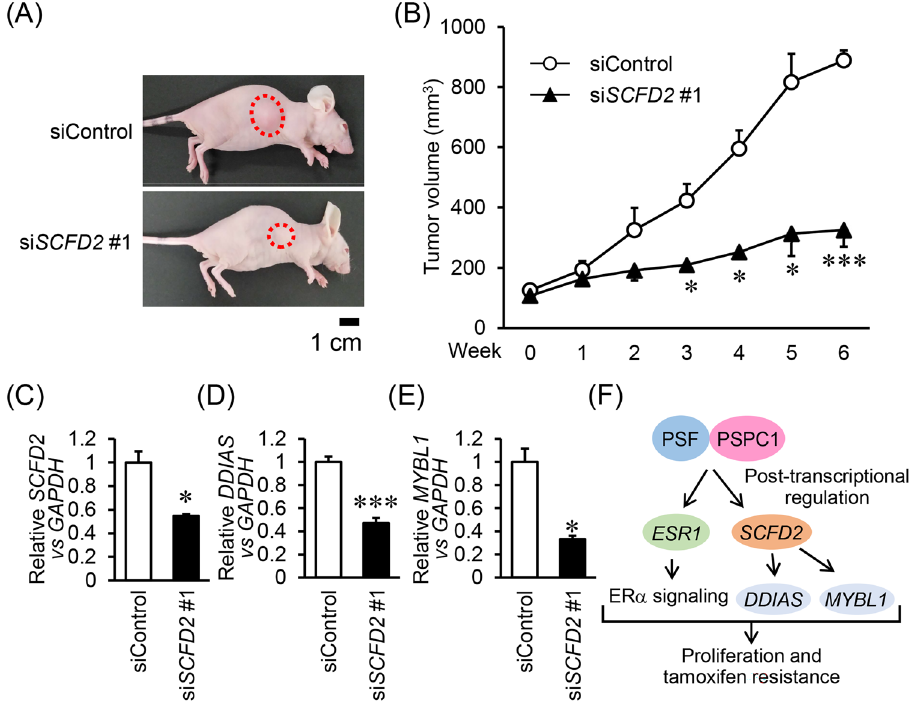
Figure 5. SCFD2-targeted siRNA suppresses in vivo tumor growth of tamoxifen-resistant breast cancer cells. ( A ) Representative images of xenografted mice at the day of sacrifice. ( B ) Effect of si SCFD2 #1 on growth of OHTR-derived xenograft tumors in athymic mice. Indicated siRNAs were intratumorally injected into xenografted mice twice a week. Tumor volumes are presented as mean ± SEM ( n = 4). ( C – E ) Expression of SCFD2 ( C ), DDIAS ( D ), and MYBL1 ( E ) mRNAs in OHTR-derived tumors. Relative expression levels of these mRNAs were normalized to GAPDH mRNA level in each sample and presented as mean fold ± SEM compared with siControl ( n = 4). * P < 0.05; *** P < 0.001, Student’s t -test. ( F ) Schematic image for a potential role of PSPC1/ PSF/SCFD2 axis in ER-positive breast